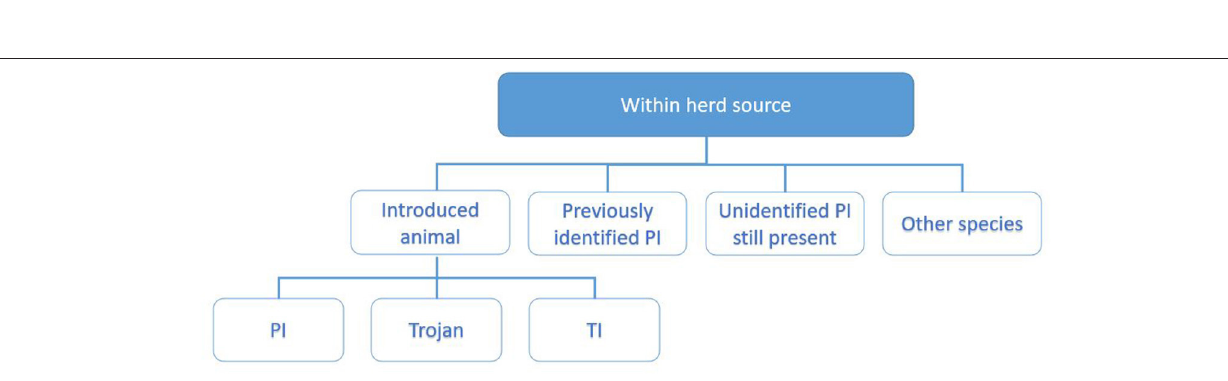
Alternatively, the birth of multiple positive calves could also of time while all dams were within the window of